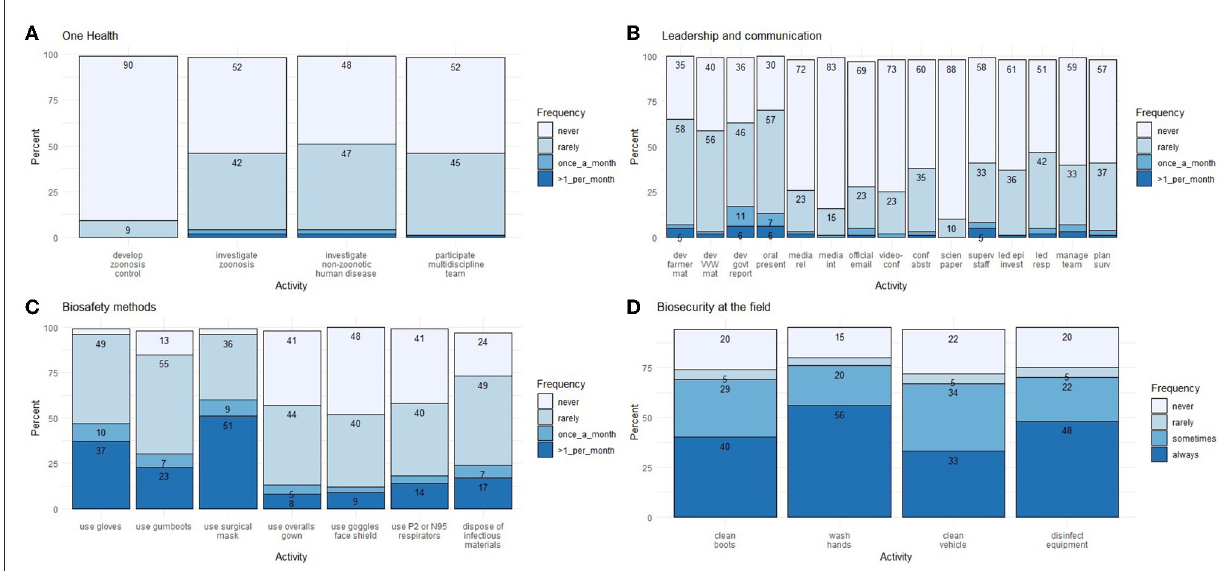
FIGURE3 Percentage frequency distribution of respondent’s activity regarding One Health (A) , leadership and communication (B) , biosafety methods (C) and biosecurity at the field (D) from an online veterinary epidemiology capacity cross-sectional study in Lao PDR between February and March 2021. The percentage may not sum to 100 due to rounding. Key labels on the x-axis: dev, develop; mat, materials; VVW, village veterinary worker; govt, government; rel, release; int, interview; conf, conference; abstr, abstract; scien, scientific; superv, supervise; epi = epidemiological; invest, investigation; resp, response; surv, surveillance.